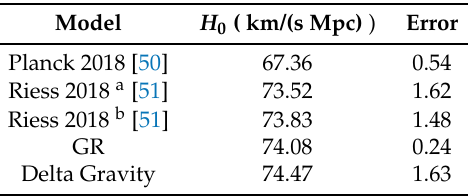
Table 4. H 0 values found by MCMC with SN-Ia Data, assuming M V = − 19.23. Furthermore, we tabulate Planck [50] and Riess [51] H 0 values.